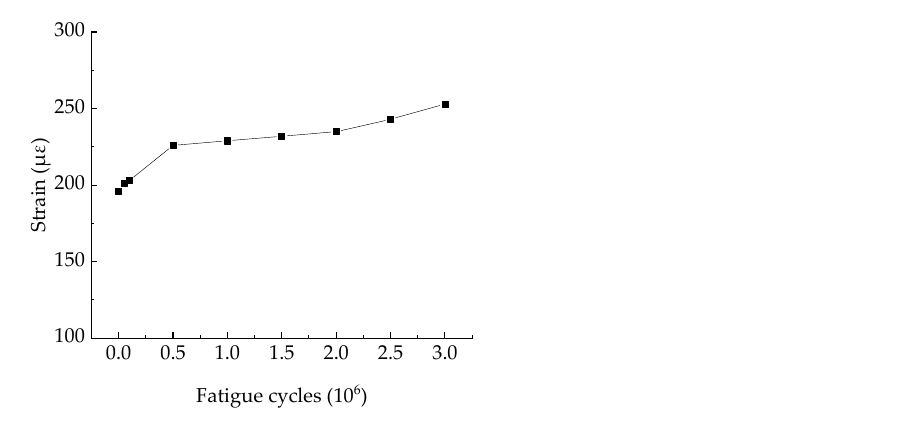
Figure 21. The relationship between the reinforcement strain and fatigue cycles of the reinforced P3.